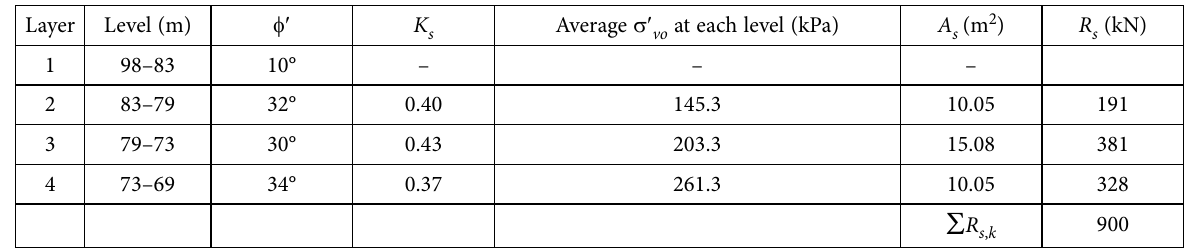
Table 4. Shaft ultimate resistance R